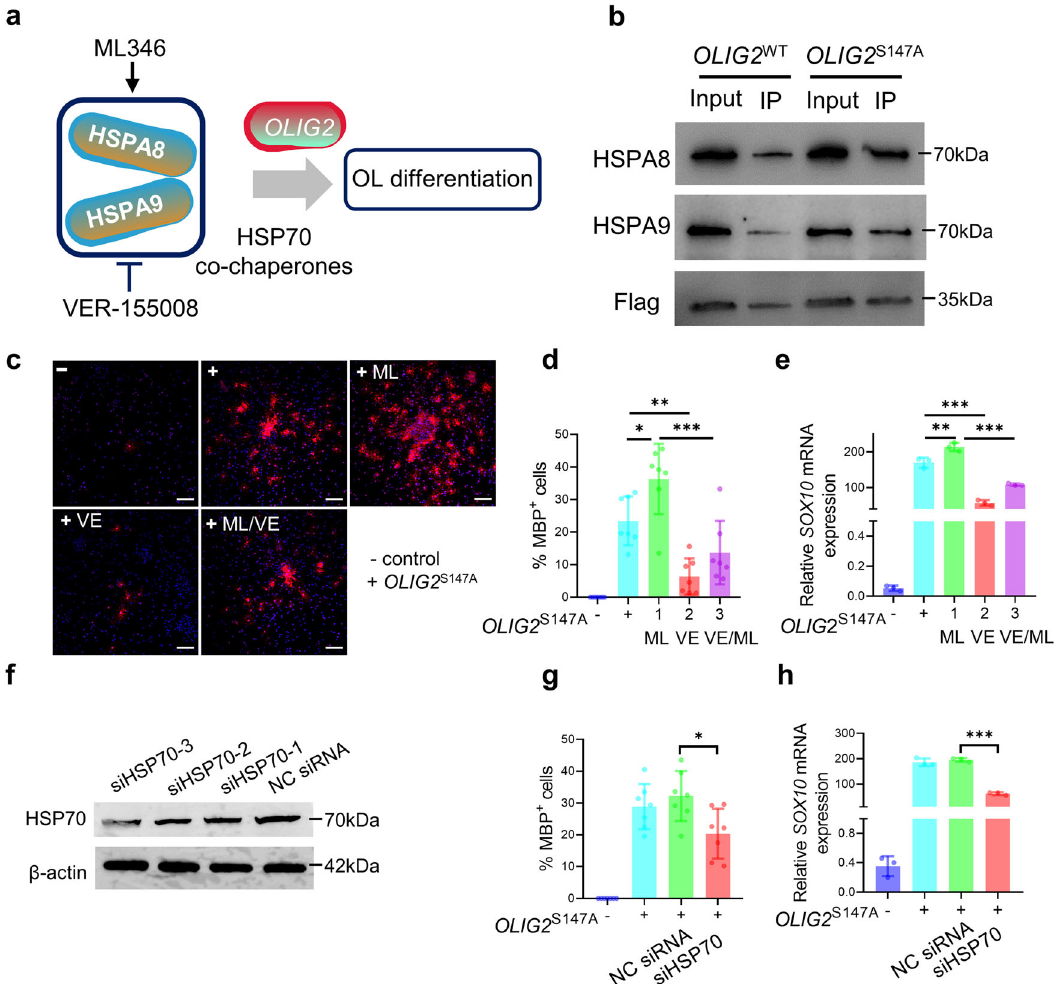
Fig. 6 The HSP70 complex binds to OLIG2 and promotes OLIG2 -driven smRNA-induced OL differentiation. a Diagram of the HSP70 complex and our working model. Two main nuclear components of HSP70 were identi fi ed in our study. The HSP70 agonist VE and antagonist ML were utilized to induce and inhibit HSP70, respectively. b hiPSC1-derived NPCs were transfected with OLIG2 WT or OLIG2 S147A smRNA for 24 h, and nuclear proteins were extracted for Flag IP. The IP samples were immunoblotted to assess the levels of components of the HSP70 complex. c VE and ML were administered along with OLIG2 S147A smRNA during OL differentiation. MBP-positive OLs were detected on day 21 of differentiation; scale bar, 100 μ m. d Quanti fi cation of the percentage of MBP-positive cells in the cultures ( n = 7; * p < 0.05, ** p < 0.01, and *** p < 0.001, using one-way ANOVA tests). e hiPSC1-derived NPCs underwent 6 daily transfections of OLIG2 S147A mRNAs and treated with VE and ML. At 24 h after transfection, the mRNA expression of SOX10 was quanti fi ed by qPCR ( n = 3; ** p < 0.05, *** p < 0.001 using using one-way ANOVA test). f Knockdown of HSP70 in hiPSC1-derived NPCs. g Quanti fi cation of the percentage of MBP-positive cells in the cultures ( n = 7; * p < 0.05 using one-way ANOVA test). hiPSC1-derived NPCs were transfected with siHSP70 along with OLIG2 S147A smRNA, OL differentiation was induced, and MBP-positive OLs were detected on day 21 of differentiation. h qPCR analysis of SOX10 mRNA expression levels. hiPSC1-derived NPCs were transfected with siHSP70 along with OLIG2 S147A smRNA, and OL differentiation was then induced. At 24 h after transfection, SOX10 mRNA expression was quanti fi ed by qPCR ( n = 3; *** p < 0.001, using one-way ANOVA